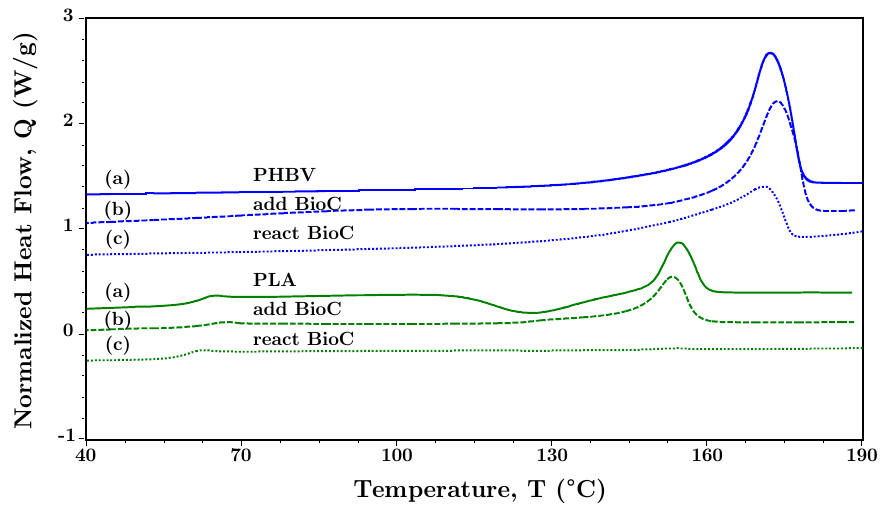
Figure 8. DSC of the melting peak (endo up) of (blue) PHBV and (green) PLA showing ( a ) the neat polymer, ( b ) the neat polymer upon adding BioC in the first heating cycle, and ( c ) the same sample as in b, in the second heating cycle. The effects of mixing BioC with neat polymers is evident in the reduction of both melting peaks, resulting in the absence of a crystalline melting peak for